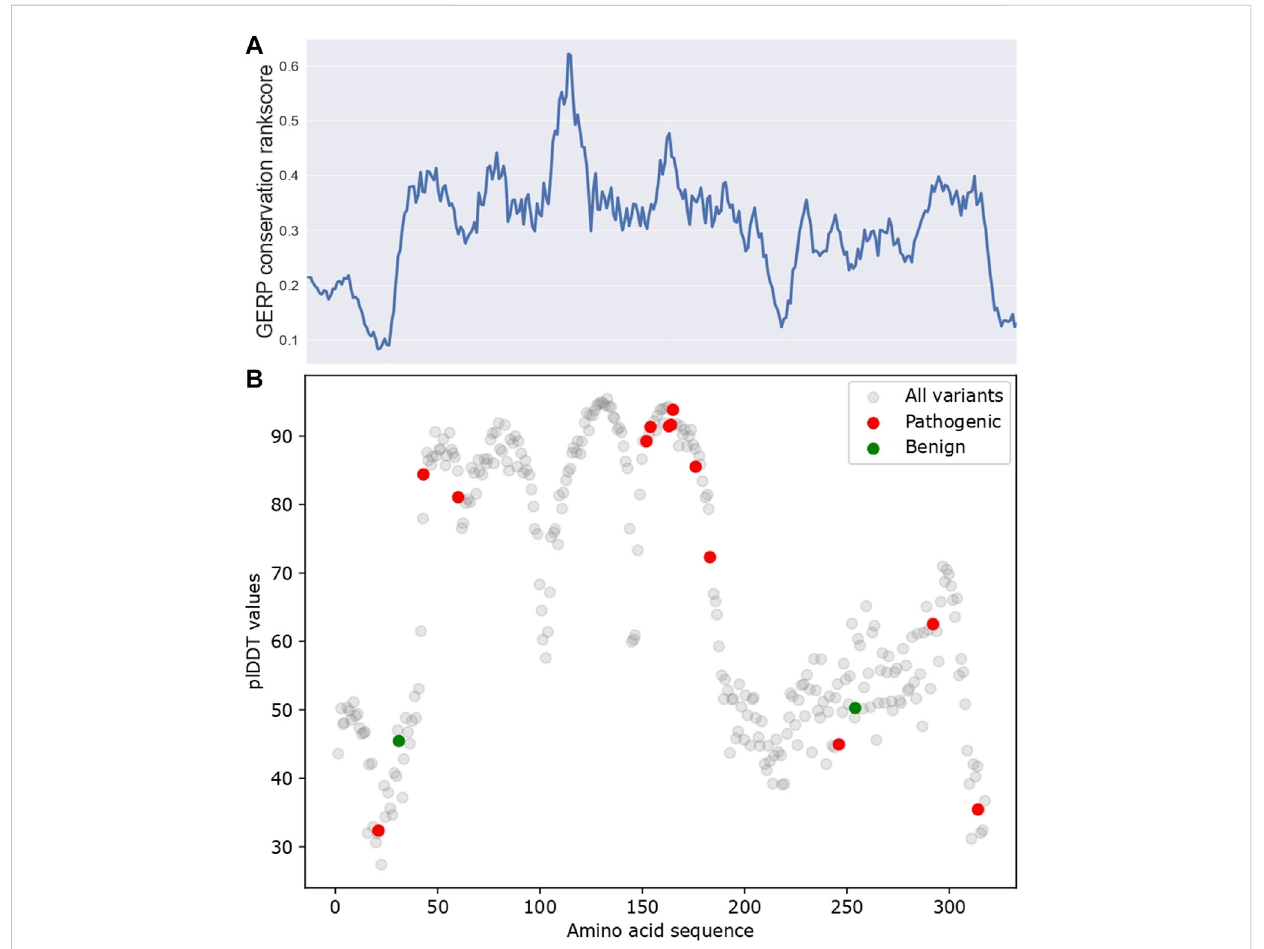
FIGURE 3 The pLDDT scores for AlphaFold predicted APOE structure. (A) GERP conservation score. (B) pLDDT scores along APOE protein sequence. ClinVar pathogenic/benignvariantswerehighlightedinredandgreen,respectively.AllvariantsarereferredtoasallaminoacidsinAPOE,whichre fl ectthepLDDT distribution for all amino acids of